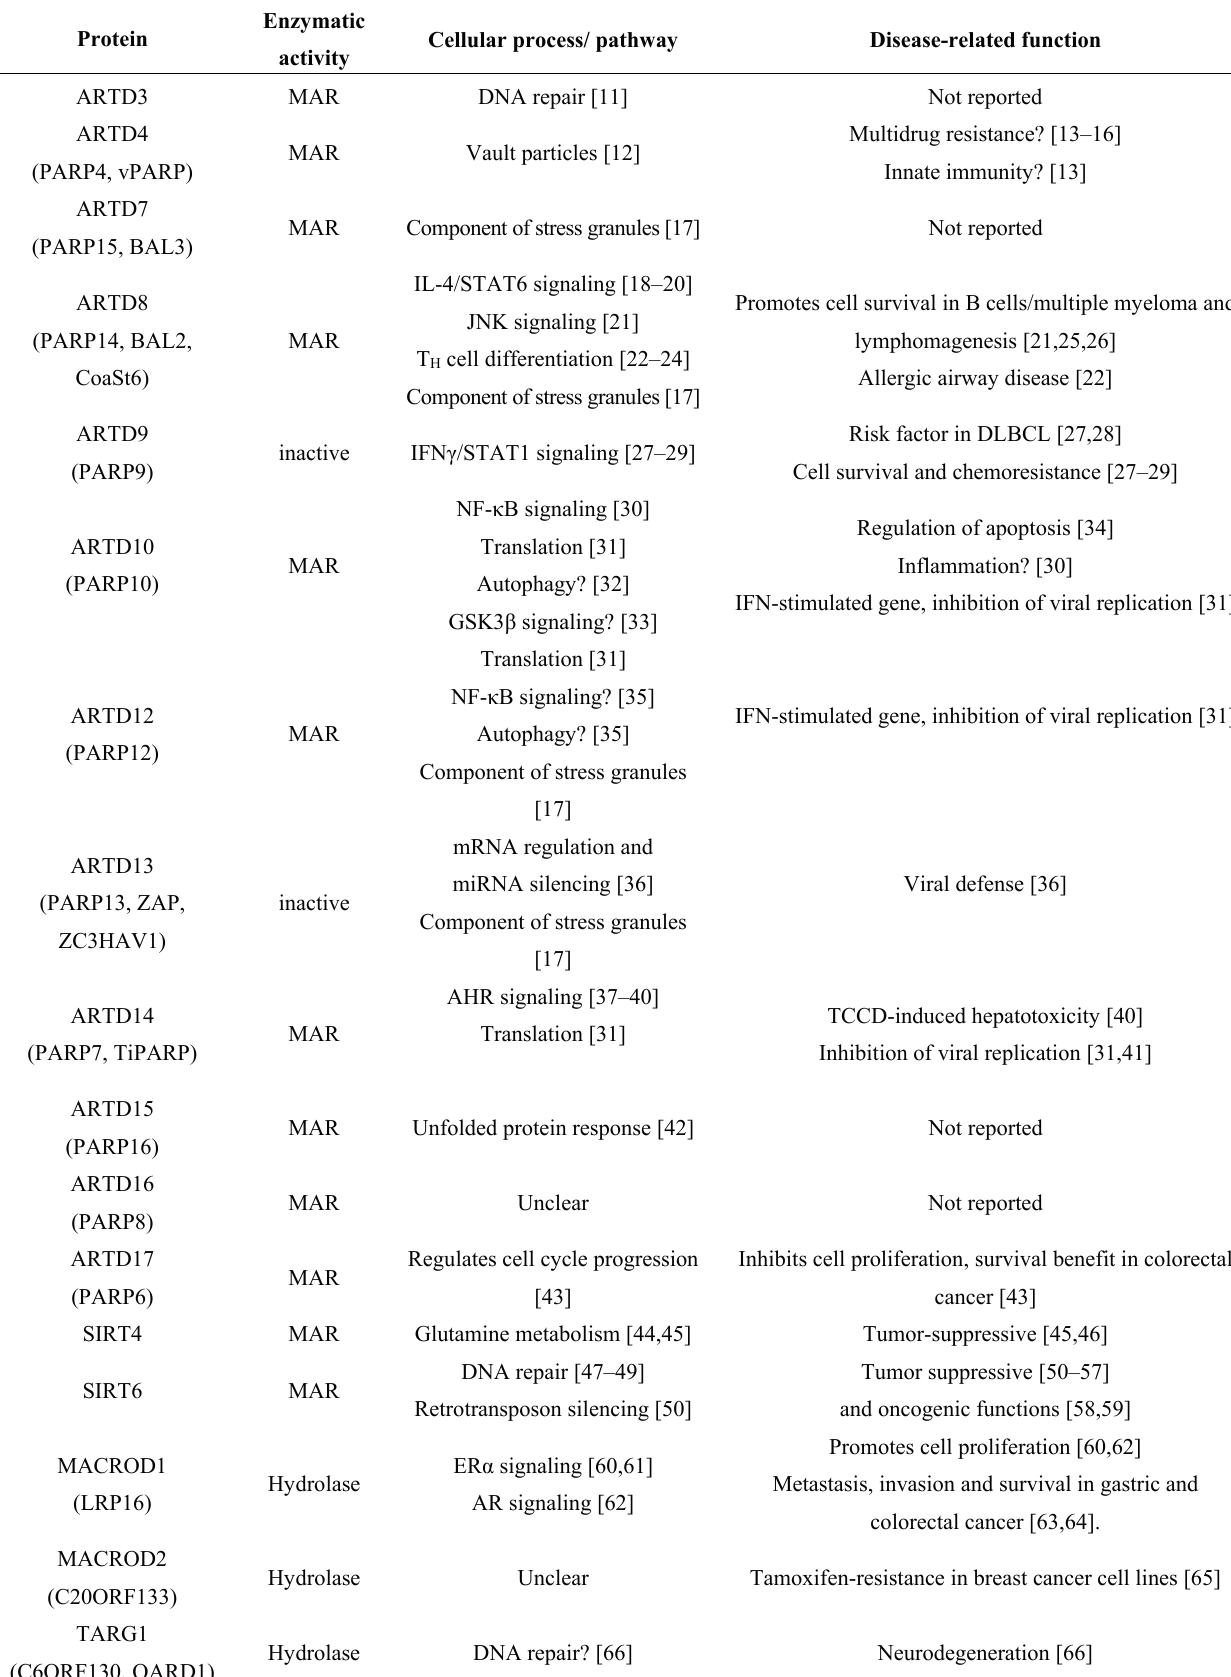
Table 1. MARylation in signaling and